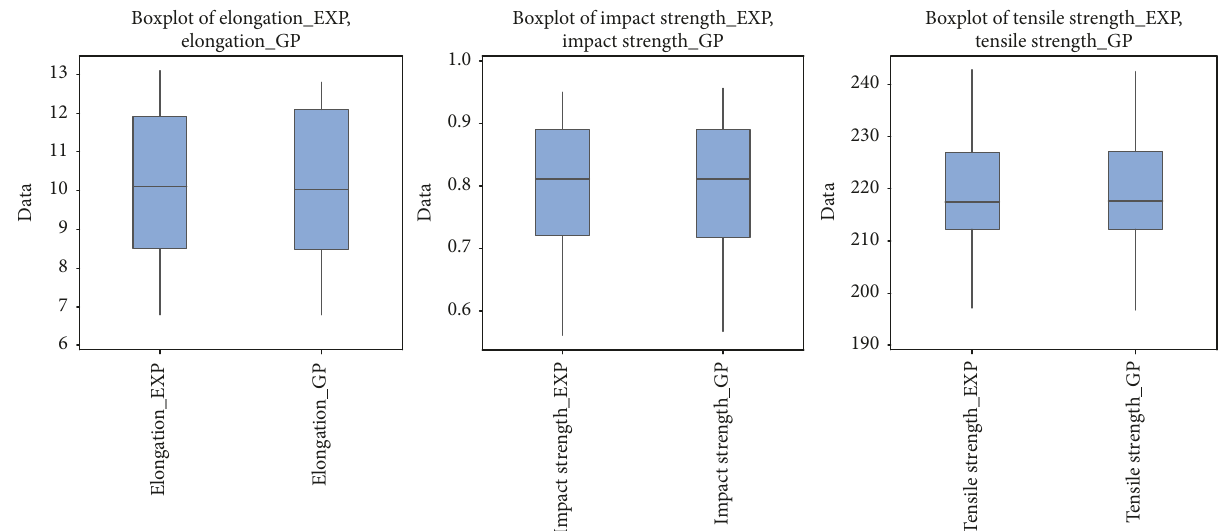
Figure 7: The quality distribution of GP models and experimental work of different outputs of FSW